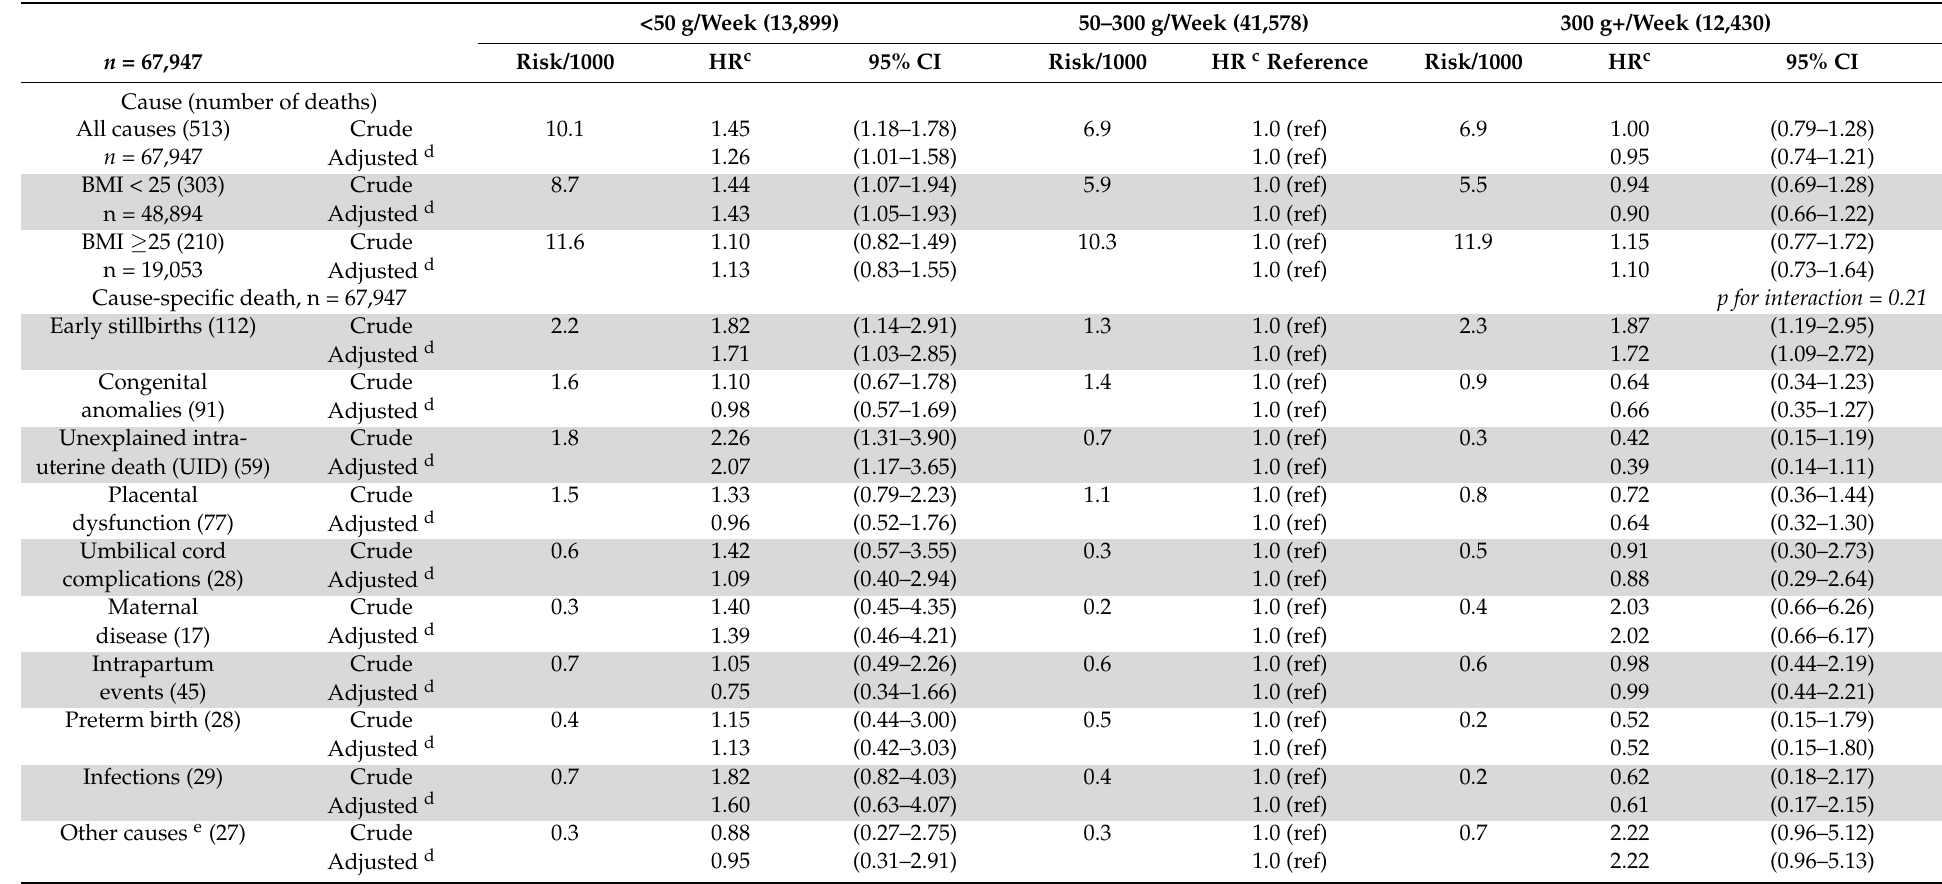
Table 4. Risk of cause-specific stillbirth a or neonatal death a according to early gestational weight gain b